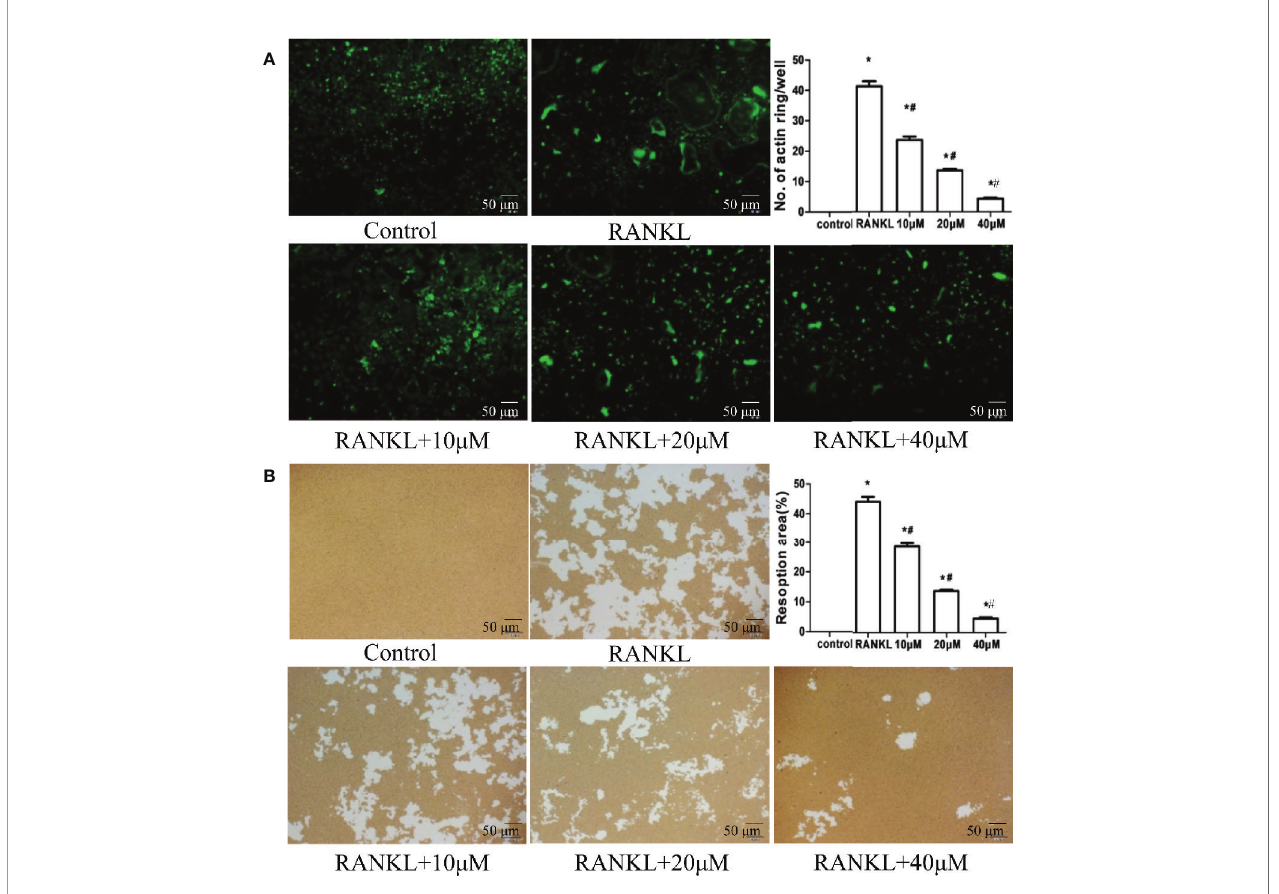
FIGURE 2 | Muscone represses actin-ring formation and bone resorption by osteoclasts. (A) Actin-ring formation is observed by FITC-phalloidin staining and quanti fi ed. Muscone inhibits the actin-ring formation in a dose-dependent manner. (B) Resorption area is quanti fi ed by image analysis, and muscone signi fi cantly shrinks the resorbed range in a dose-dependent manner. *P < 0.05 vs. the control group, # P < 0.05 vs. the RANKL-induced group (original scale bars, 50 m